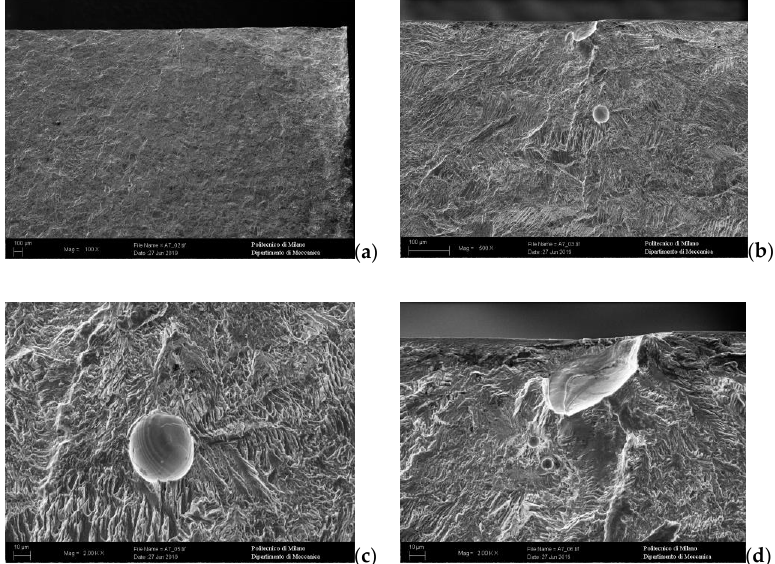
Figure 11. Tooth A7—the nucleation zone is remarked in ( a ). Surface and subsurface porosities have been observed in the nucleation zone ( b ). The pore diameter is about 40 m ( c ). Close to the surface defects, two smaller porosities are clearly visible; the surface defect is about 50 µm deep and 60 µm width ( d ).